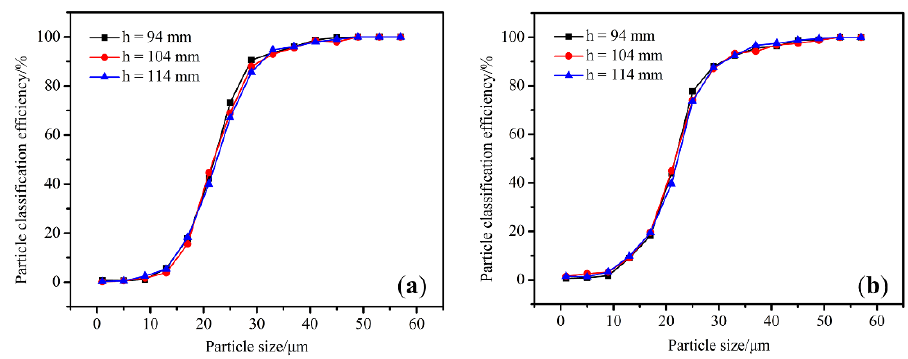
Figure 20. Tromp curves for different height diversion cone classifiers: ( a ) T-C (1-0.8) and ( b ) T-D (1-0.7) .